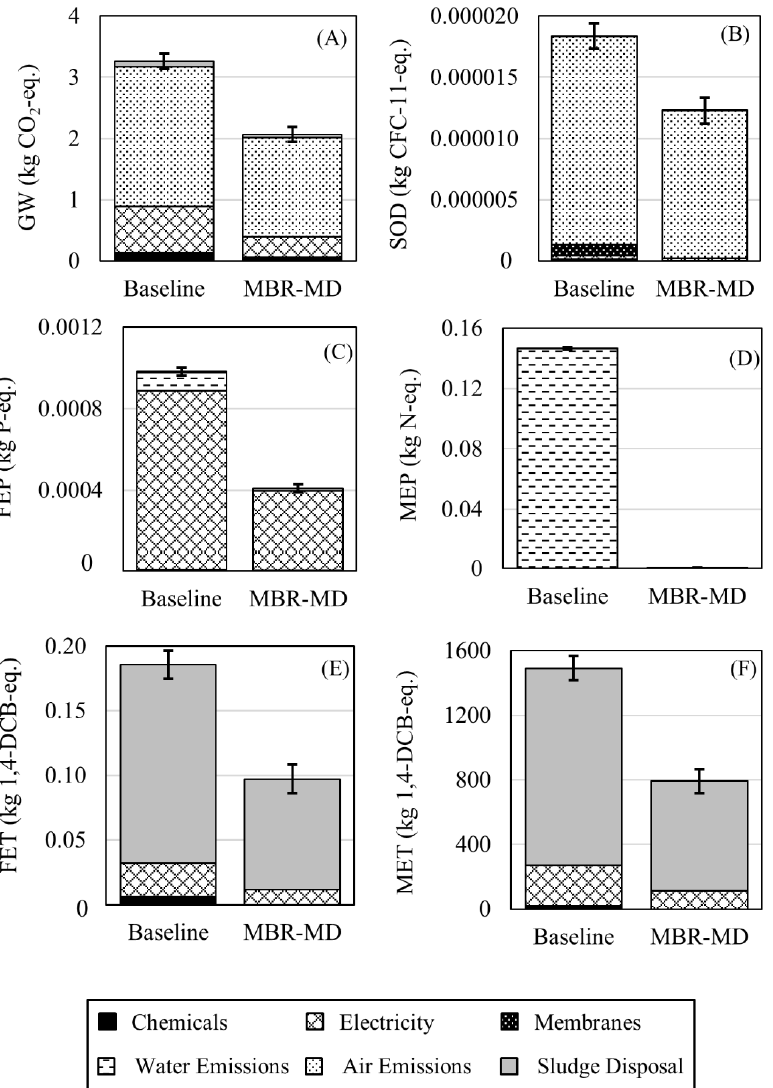
Figure 5. Total environmental impacts for the Baseline and MBR-MD (MBR-MD-0) systems for ( A ) GW, ( B ) SOD, ( C ) FEP, ( D ) MEP, ( E ) FET, and ( F ) MET impact categories. Error bars represent the standard deviation from uncertainty analysis of the total environmental impacts in each category.